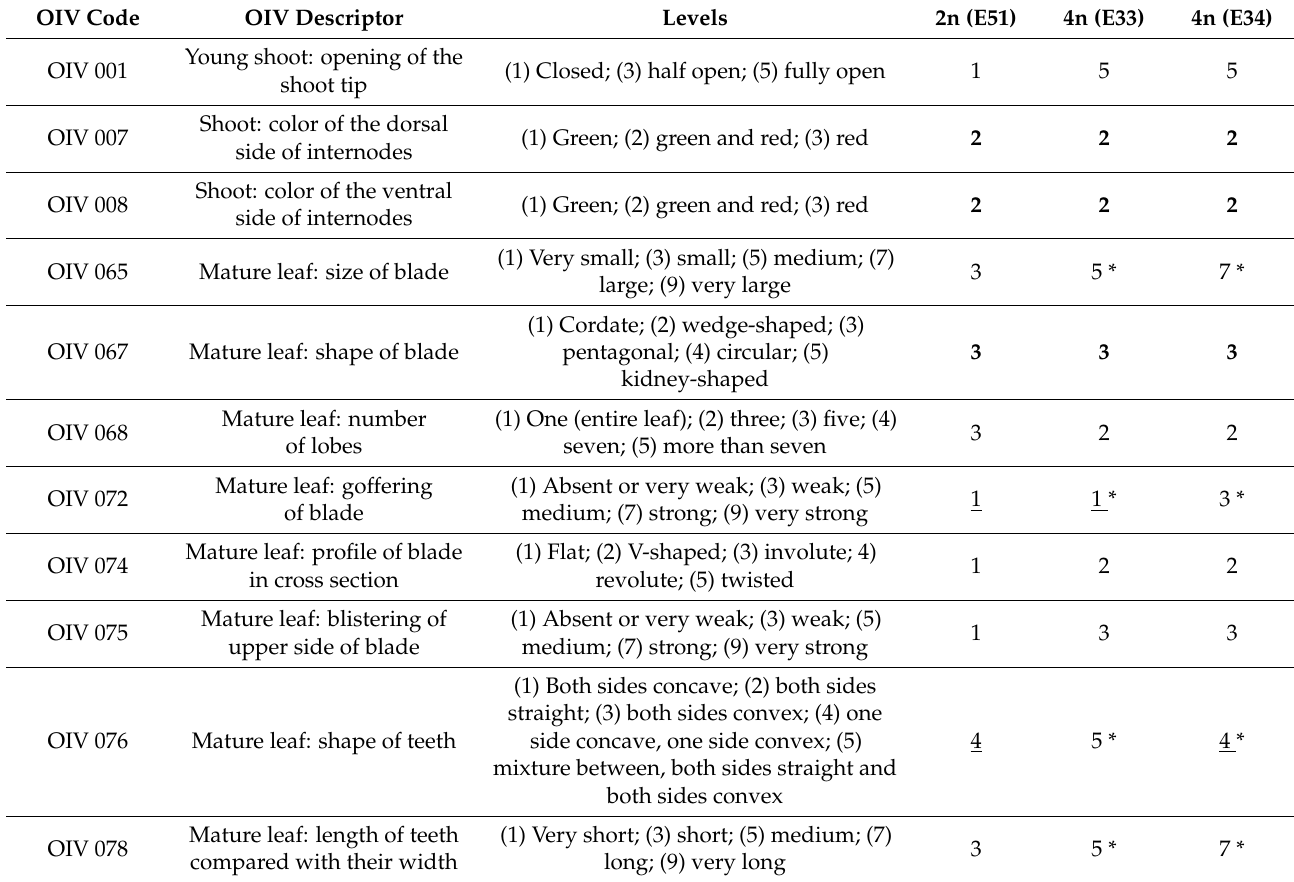
Table 1. Ampelographic characteristics of 2n and 4n regenerants based on the 15 OIV descriptors used (OIV, 2009). OIV